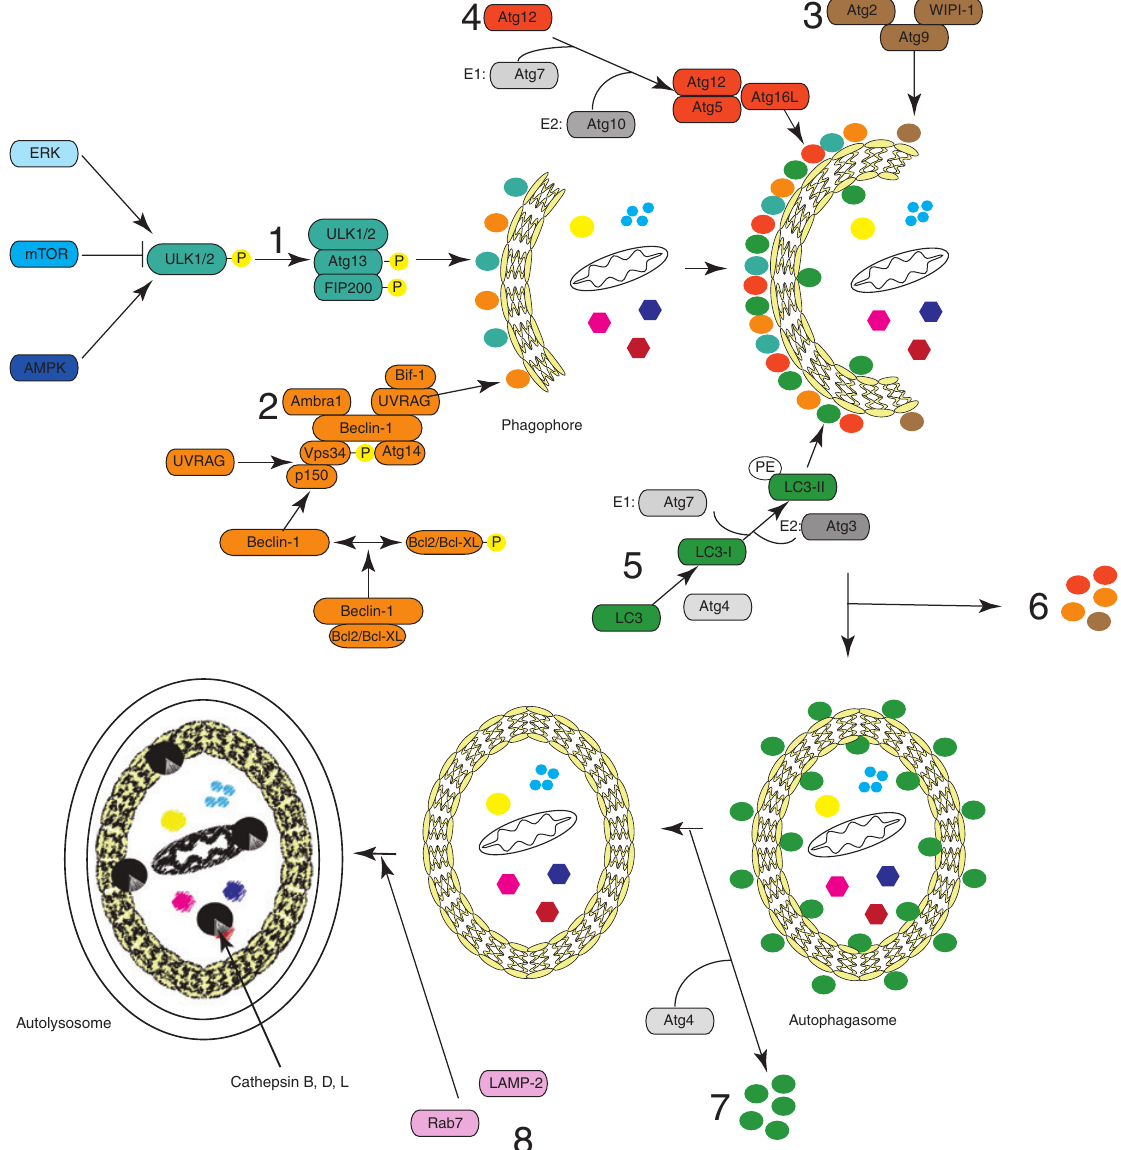
Figure 4: Autophagy is a tightly regulated, catabolic process which plays an essential role in cellular homeostasis and muscle health. Beclin1 forms important interactions with several proteins: UVRAG (UV radiation resistance-associated gene protein); Atg14 (autophagy- related protein 14); Vps34 (vacuolar protein sorting 34); p150; Bif-1 (Bax-interacting factor 1); Ambra1 (activating molecule in Beclin1-regu- lated autophagy). Together these form a class III phosphoinositide 3-kinase complex (PtdIns3K complex) and results in the formation of the pre-autophagosomal membrane. The formation of the autophagosomal membrane is mediated by the formation of the Atg12-Atg5 complex (via Atg7 and Atg10) followed by binding to Atg16L. The processing of LC3 (microtubule-associated protein 1A/1B-light chain 3) to LC3-I (by Atg4), LC3-I to LC3-II (by Atg7 and Atg3), and the conjugation of LC3-II with phosphatidylethanolamine (PE) allows binding to the growing membrane. Atg9 plays a role as a carrier supplying membrane to the growing